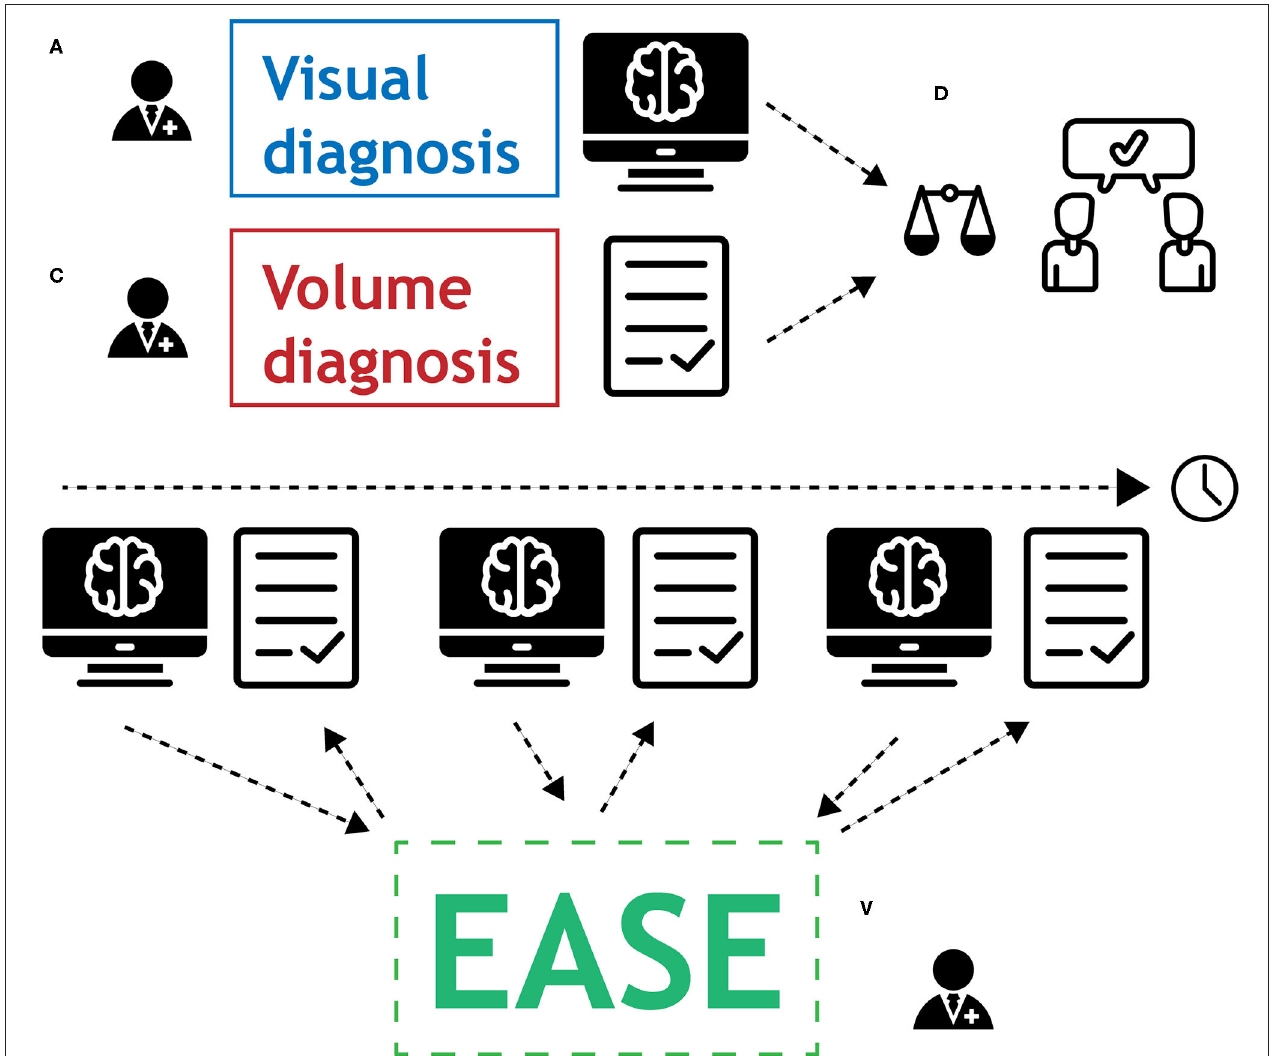
FIGURE 4 | Graphical representation of the protocol for the use of EASE in clinical practice. (A) Radiologist applies conventional method for visual diagnosis. (B) Segmentations are produced by EASE and assessed separately. (C) Radiologist interprets volume measurements. (D) If volume measurements lead to change in diagnosis, a second radiologist is consulted for a consensus